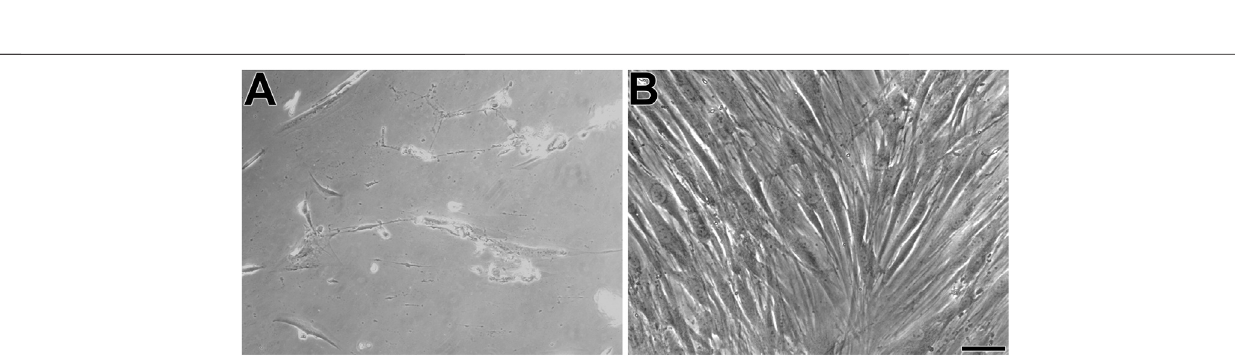
FIGURE 2 | Vimentin expression present as fi lamentous network in hPLF (A, C) and hPLF-hTERT (D, F) demonstrating the mesenchymal origin in both cell lines. Hoechst 33258 was used for nuclear counterstaining (B, C, E, F) . Scale bar: 20 µm.